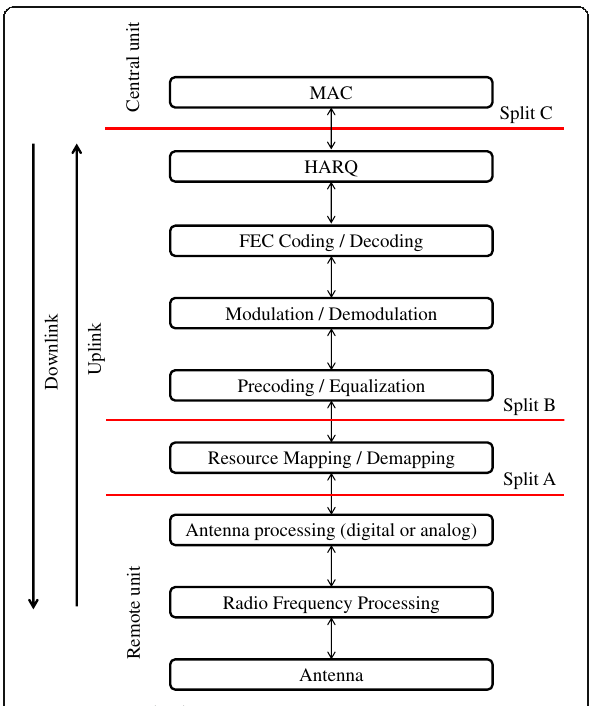
Fig. 1 Functional split